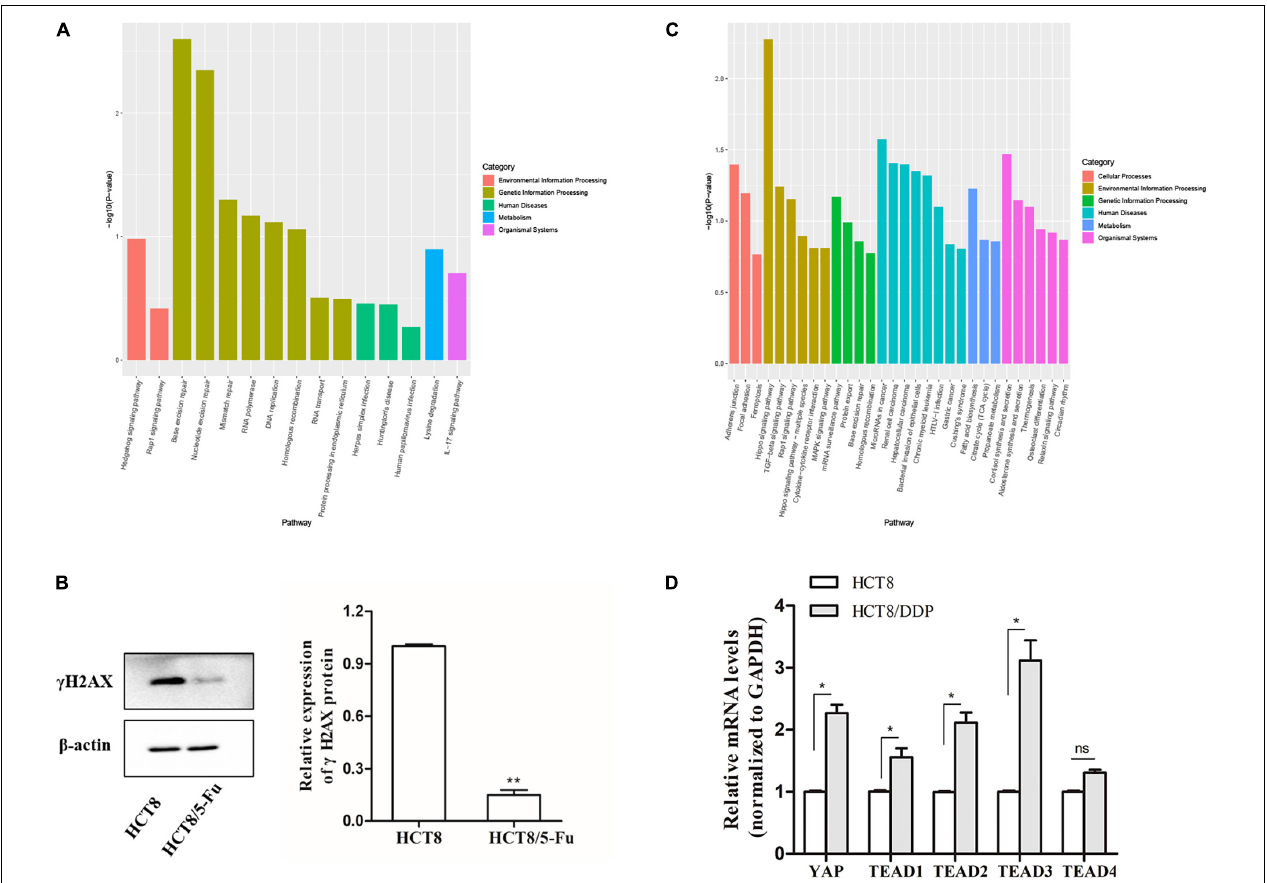
FIGURE 4 | Kyoto Encyclopedia of Genes and Genomes enrichment analysis of host genes of DE-circRNAs. (A) Significantly enriched signaling pathways of the DE-circRNAs in HCT8/5-Fu cell lines. (B) The expression of γ H2AX in HCT8 and HCT8/5-Fu cells was detected via Western blotting. (C) Significantly enriched signaling pathways of the DE-circRNAs in HCT8/DDP cell lines. (D) The expression of key genes of Hippo signaling in HCT8 and HCT8/DDP cells was detected by qRT-PCR. n = 3, data are shown as mean ± SD, * p < 0.05; ** p < 0.01 and “ns” represents no statistical